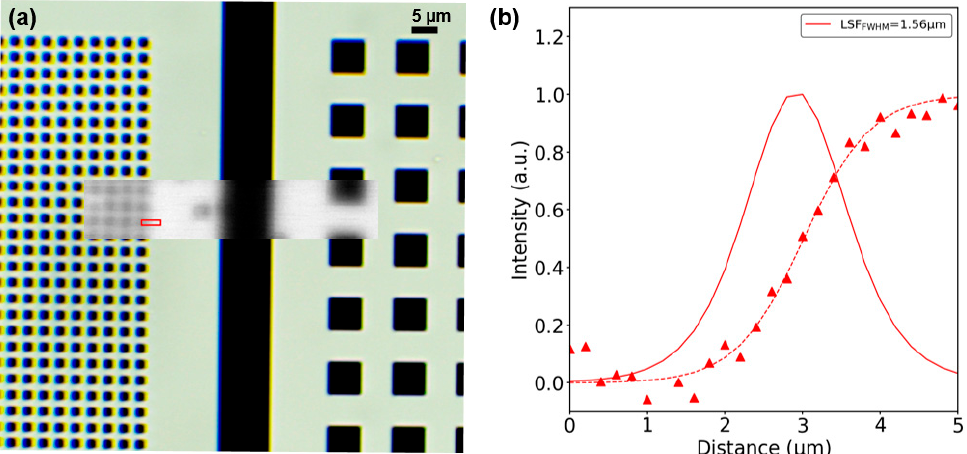
Figure 10. ( a ) Optical image of the 1.6 µ m (left) and 6.4 µ m (right) squares of the EBL pattern, with the reconstructed image of the same region superposed. ( b ) The ESF and the LSF calculated on the specified region of the inset image.